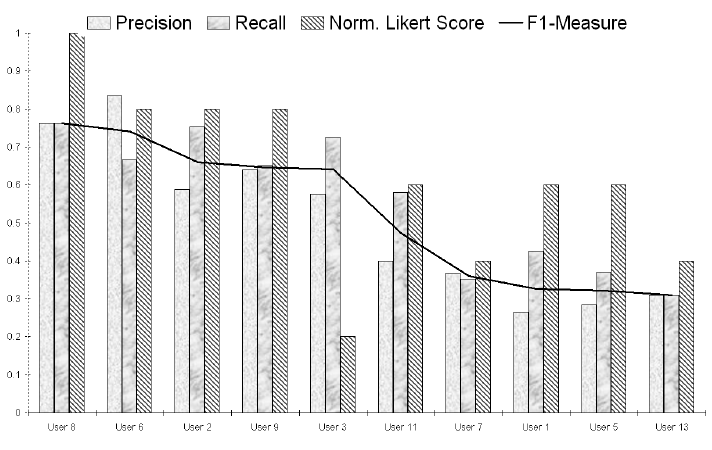
Figure 12. Effectiveness of tag suggestion for users on completely automated